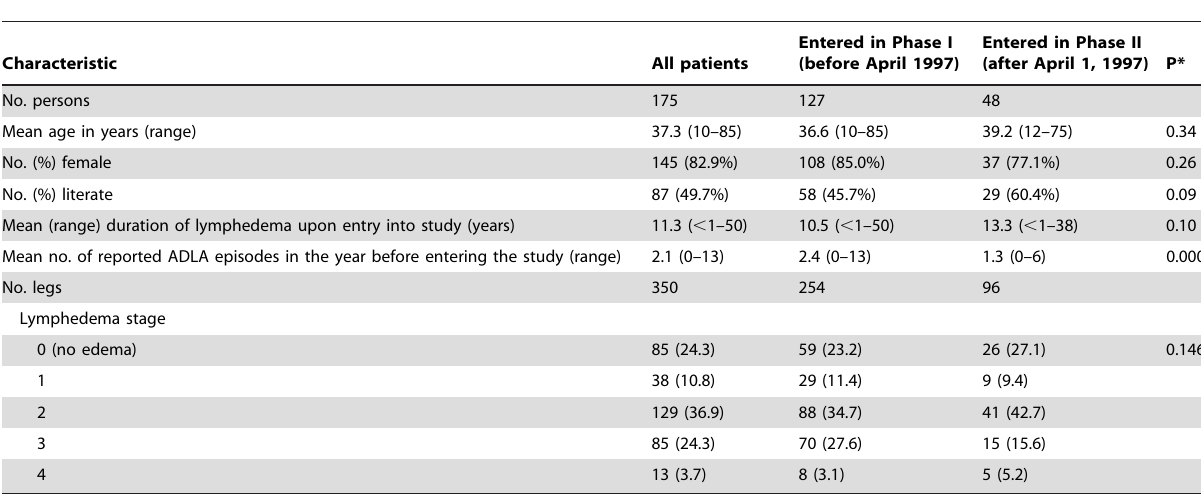
Table 1. Characteristics of 175 patients with lymphedema who participated in the study, including 127 persons who entered before April 1, 1997 (during Phase I) and 48 who entered after April 1, 1997 (Phase II), univariate